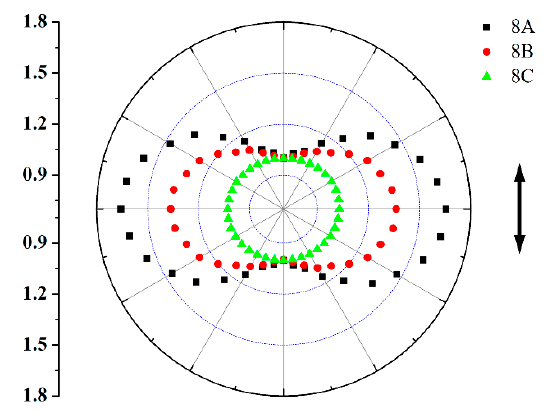
Figure 7. Polar plots of IR absorption intensities from ν (benzene ring) at 1507 cm − 1 for 8A , 8B , and 8C .